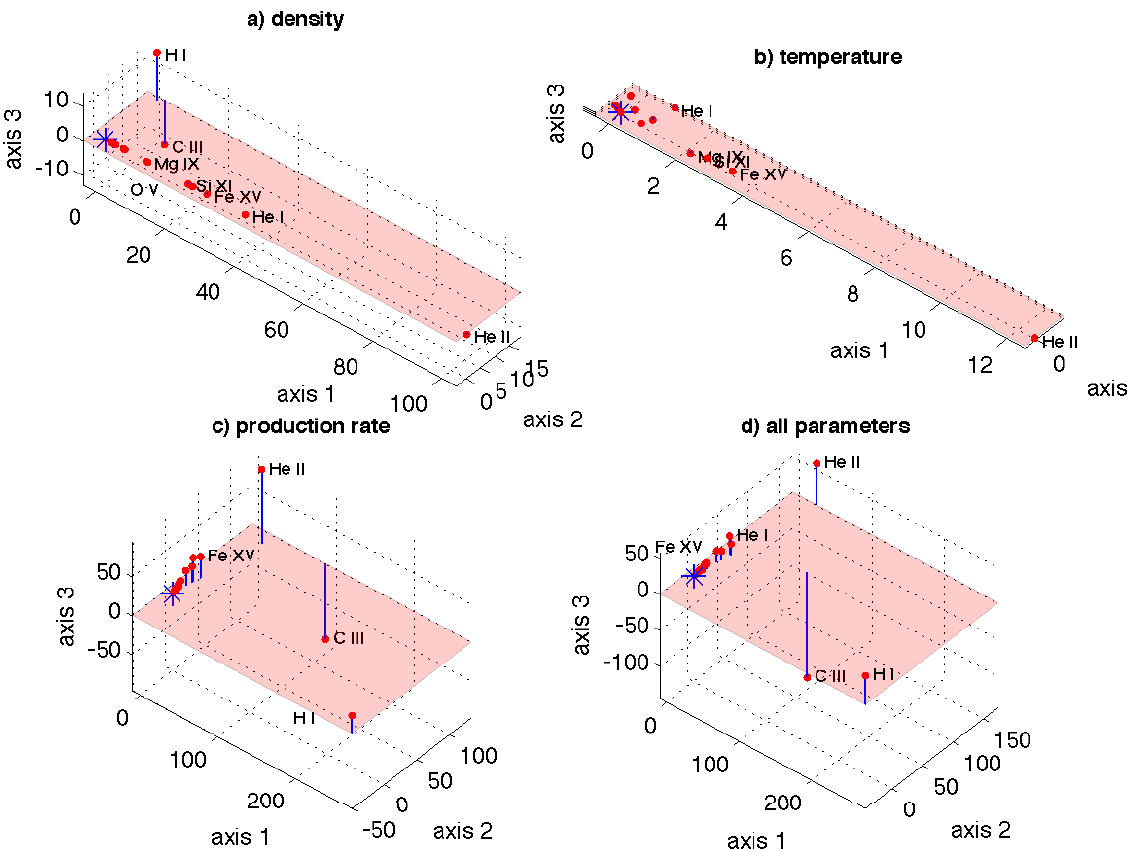
Fig. 8. Three-dimensional connectivity map of the spectral lines, in which the distance between each pair of lines reflects their degree of dissimilarity. The maps correspond to the density profile (a) , the temperature profile (b) , the production rate (c) , and all three parameters together (d) . Vertical bars are there merely as a guide to locate the lines with respect to the plane with vertical coordinate z = 0 (shown in translucent red). Only those lines are labeled, which sufficiently stand out of the clusters of